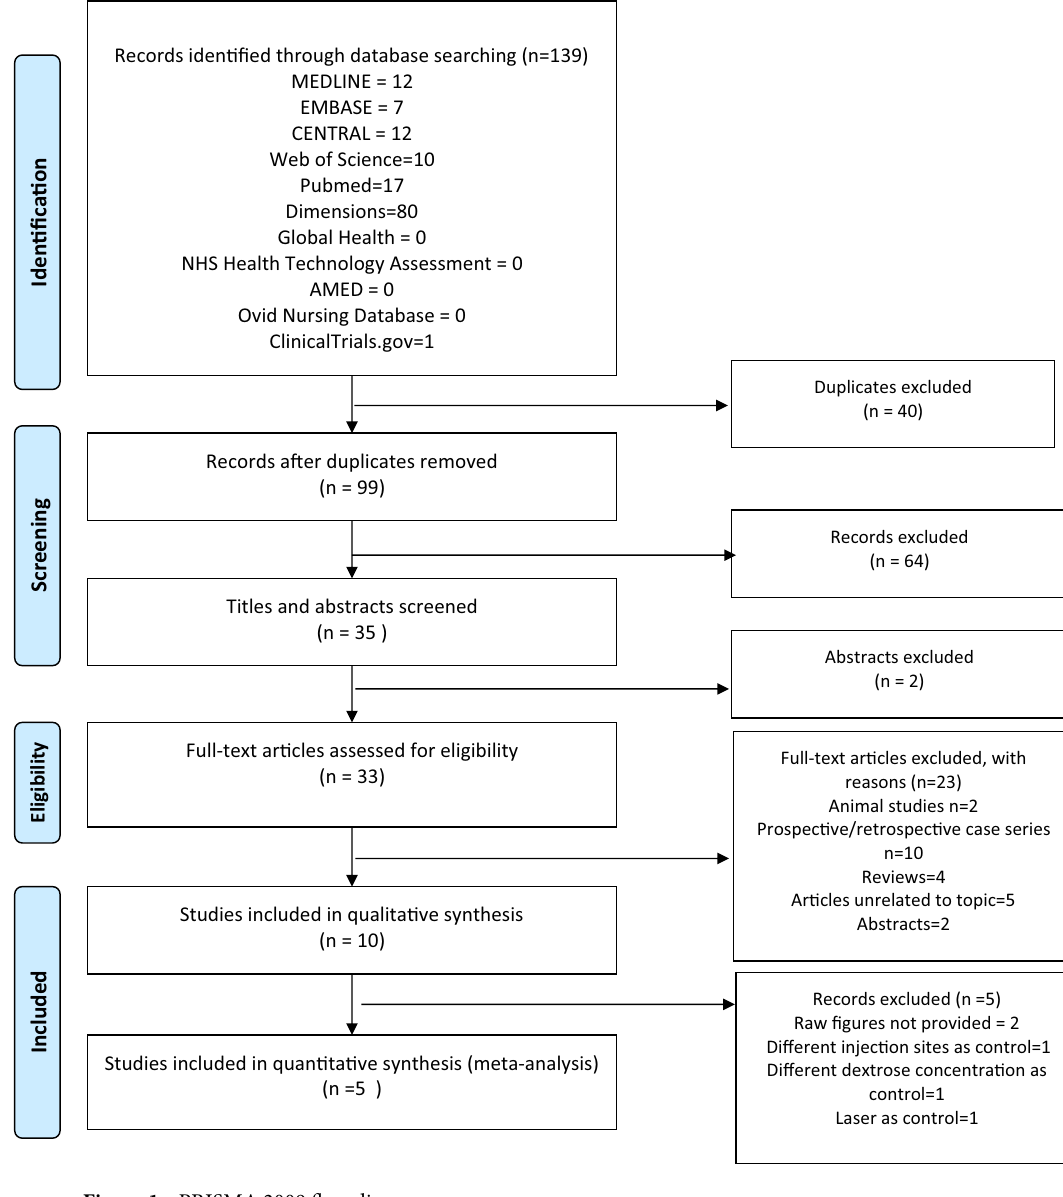
Figure 1. PRISMA 2009 flow